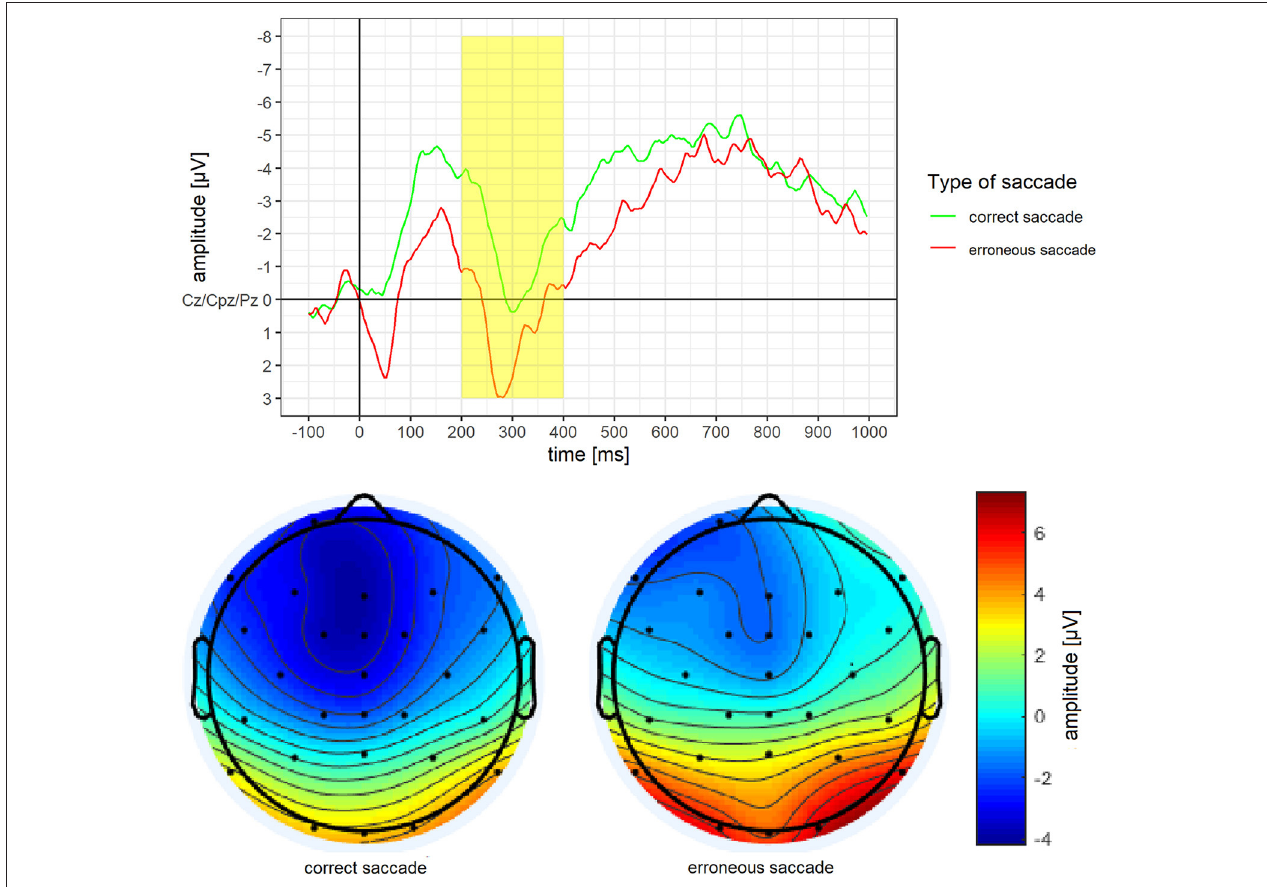
FIGURE 5 | Grand average difference wave of the P3 separately for erroneous and correct saccades. Underneath a scalp map displaying the mean voltage distribution for erroneous and correct saccades in the time window ranging from 200 to 400ms after stimulus